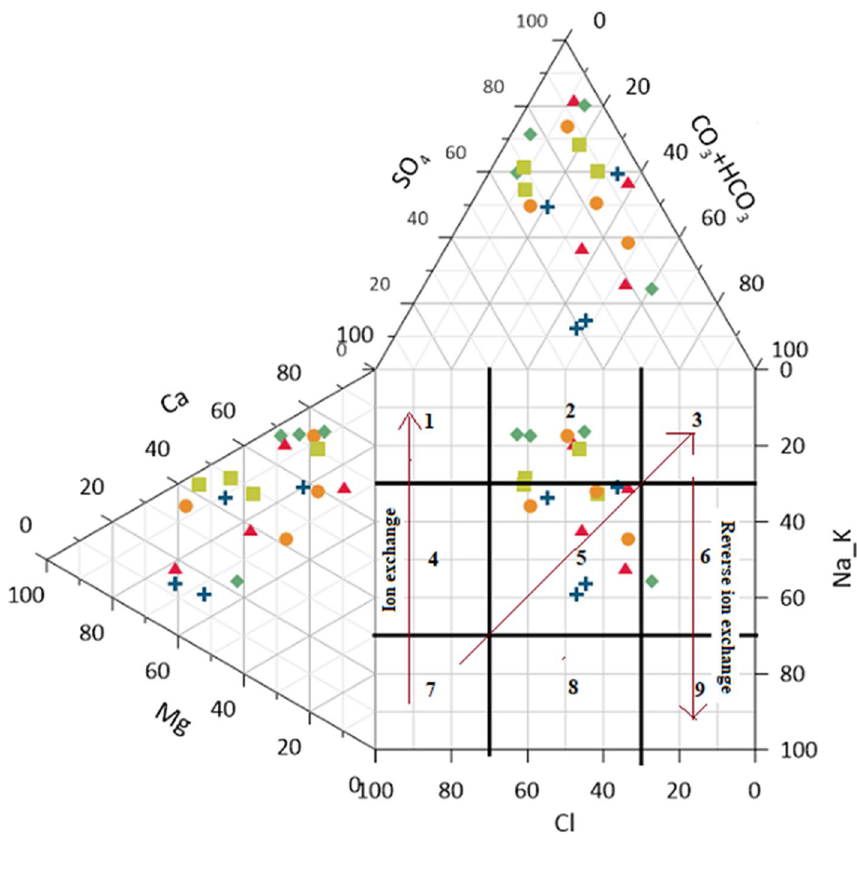
Fig. 6 Durov diagram for groundwater samples (Lloyd and Heathcote,